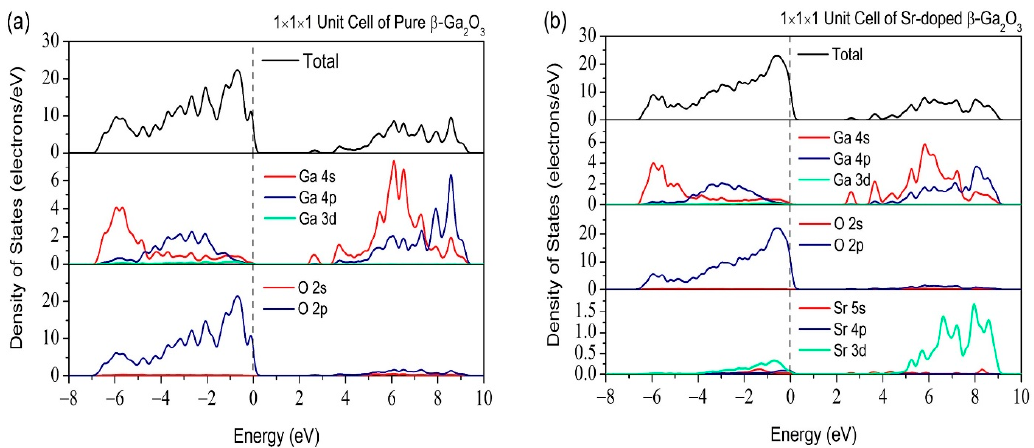
Figure 9. Total and partial density of states of ( a ) pure β -Ga 2 O 3 and ( b ) Sr-doped β -Ga 2 O 3 in 1 × 1 × 1 supercell.